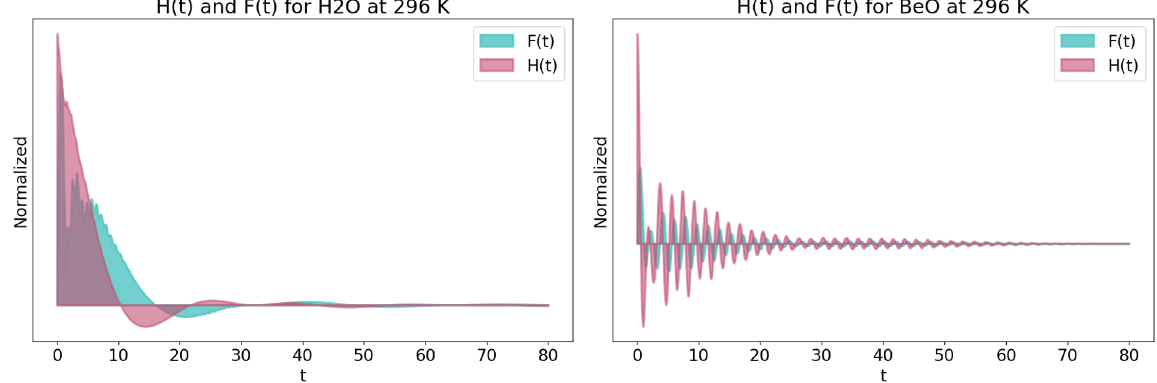
Figure 5: Convergence of F ( t ) and H ( t ) for H in H